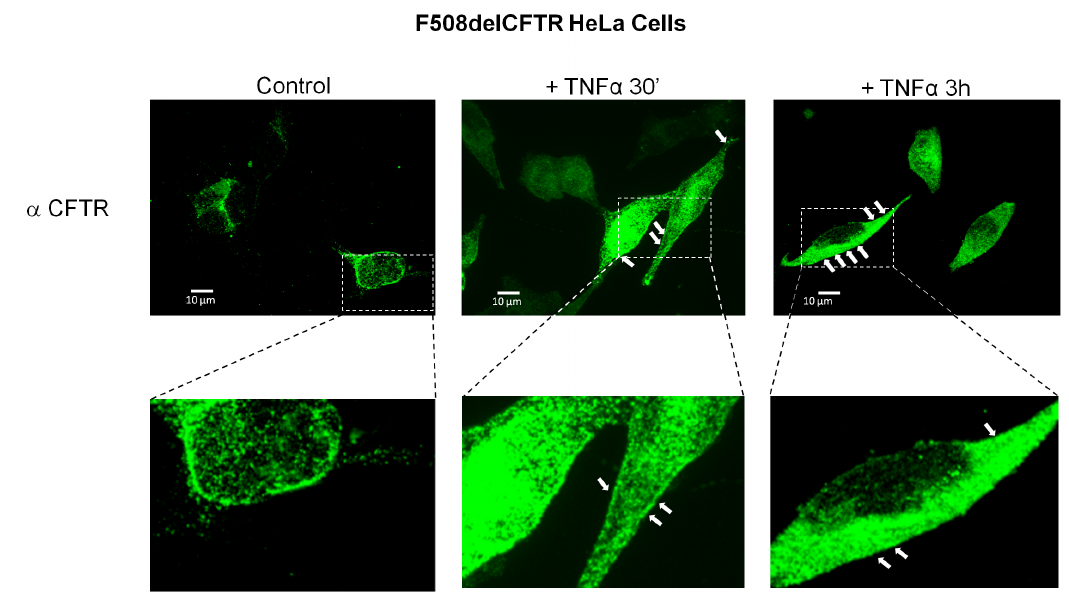
Figure 2. Localization of F508del-CFTR in HeLa cells. HeLa cells stably transfected with F508del-CFTR were subjected to CFTR immunodetection and analyzed by confocal microscopy (scale bar = 10 µm). Untreated cells (left panels). Cells treated with 50ng/ml TNF α for 30 min (middle panels). Cells treated with 50ng/ml TNF α for 3–6h (right panels). White arrows show a possible membrane localization of